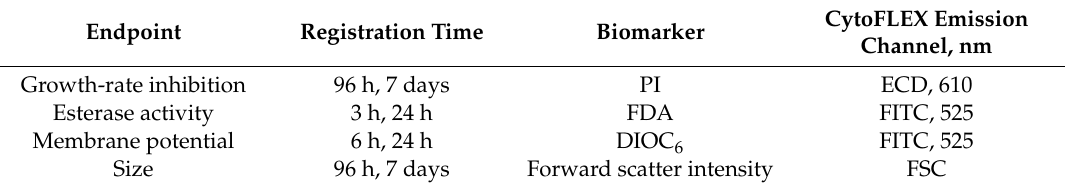
Table 2. Toxicity assessment criteria and conditions of their